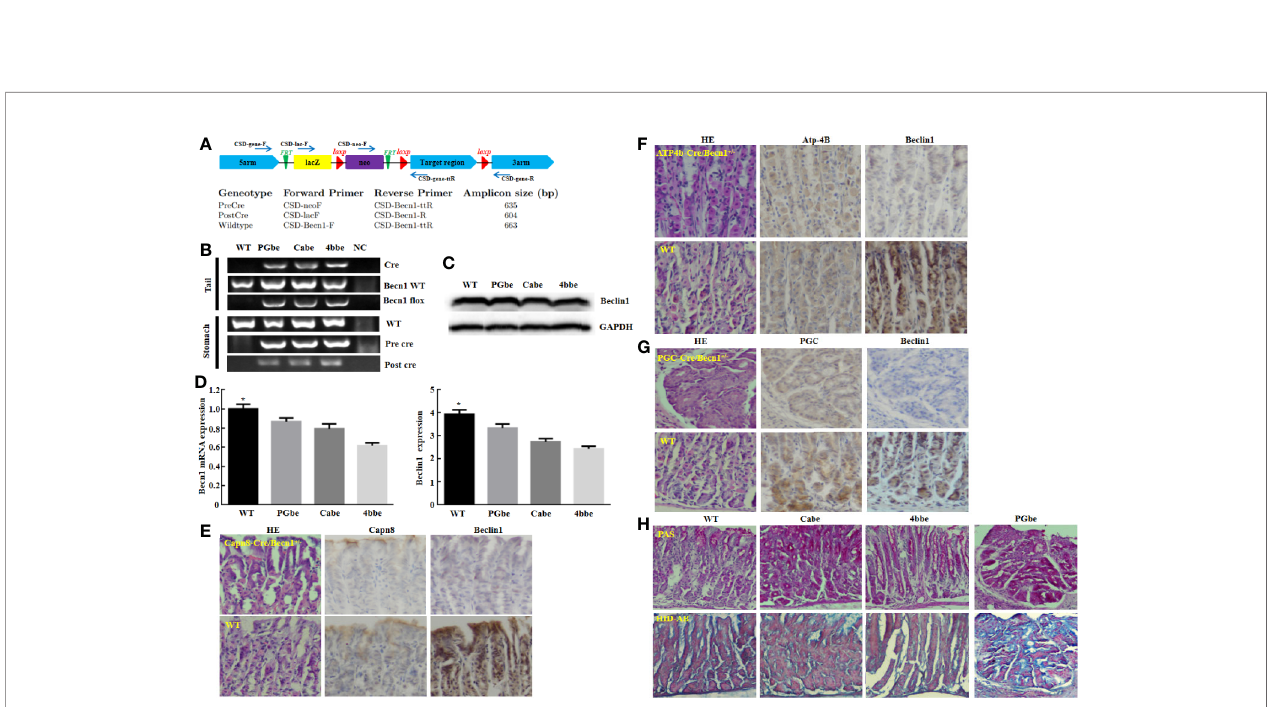
FIGURE 4 | The effects of Becn1 expression on gastric carcinogenesis. PCR primers were designed (A) and subjected to PCR of tail and stomach DNA (B) . Monoallelic deletion of Becn1 was con fi rmed by real-time PCR (C) and Western blot (D) , and couldn ’ t cause any gastric lesions although Beclin 1 expression was reduced with Capn8, Atp-4B, and PGC immunoreactivity as control according to HE and immunohistochemistry (E – G) . There was no difference in alcian blue, PAS and HID staining between three conditional knock-out mice and wild-type mice (H) . * P < 0.05, compared with the knockout mice. WT, wild-type mice; Cabe, Capn8-cre +; Becn1 +/ − ; 4bbe, Atp-4b-cre +; Becn1 +/ − ; PGbe, PGC-cre +; Becn1 +/ −